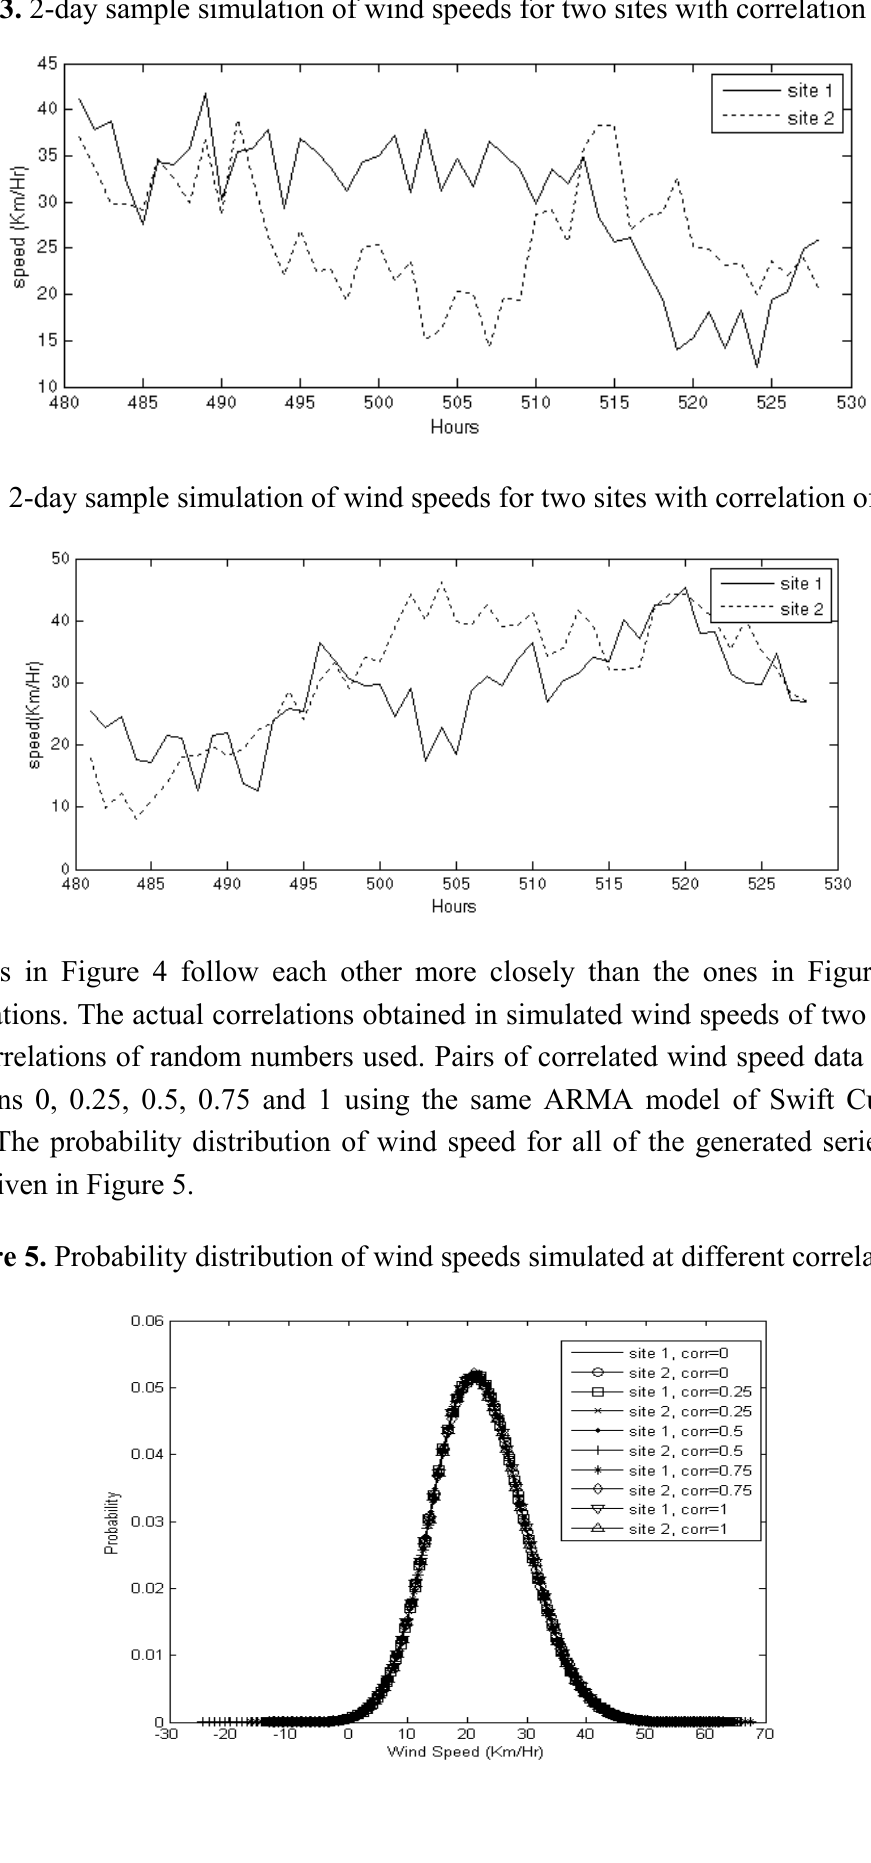
Figure 3. 2-day sample simulation of wind speeds for two sites with correlation of 0.11.